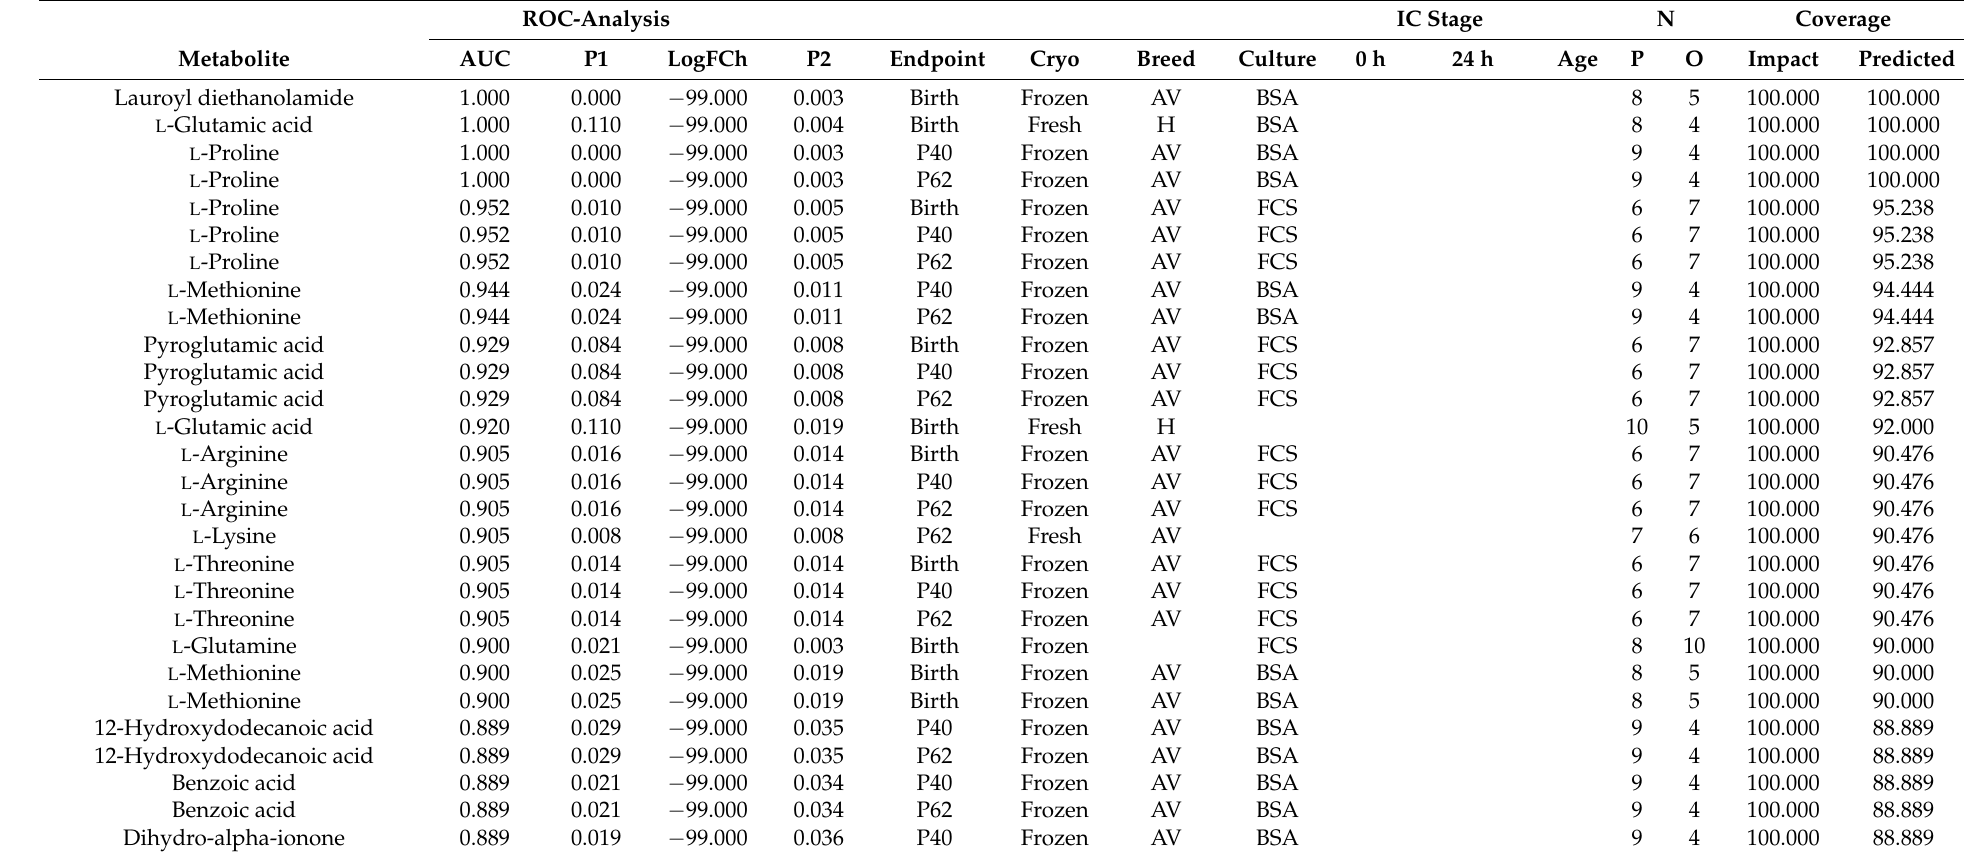
Table 4. Single metabolites that predicted pregnancy (Day-40 and Day-62) and birth (Endpoint) with >0.700 coverage within culture medium of IVP embryos transferred to recipients. Each block had specific embryo cryopreservation, bull breed and culture conditions, and is supported by embryonic stages. Embryos were sired by Holstein—H—or Asturiana de los Valles—AV—bulls, and cultured with albumin (BSA) or with albumin + fetal calf serum (FCS) followed by an individual 24 h culture step (IC stage) developmentally defined by embryonic stages at 0 h (M: morula; EB: early blastocyst; B: Blastocyst) and at 24 h (ExB: expanding blastocyst; FEB: Fully expanded blastocyst) that led to embryos aged 7, 8 and both days that were transferred fresh or frozen (Cryo) to Day-7 estrus synchronized recipients. N: samples used to calculate predictions within each metabolite block (P: pregnant; O: Open). Impact: proportions of embryos represented within IC stages developed under each culture conditions. Unfilled cells indicate the independence of this factor. P1: p -value by t -test; P2: p -value by GLM or Kruskal–Wallis test. LogFCh: logarithm of fold change pregnant/non-pregnant metabolite concentration values. AUC: area under